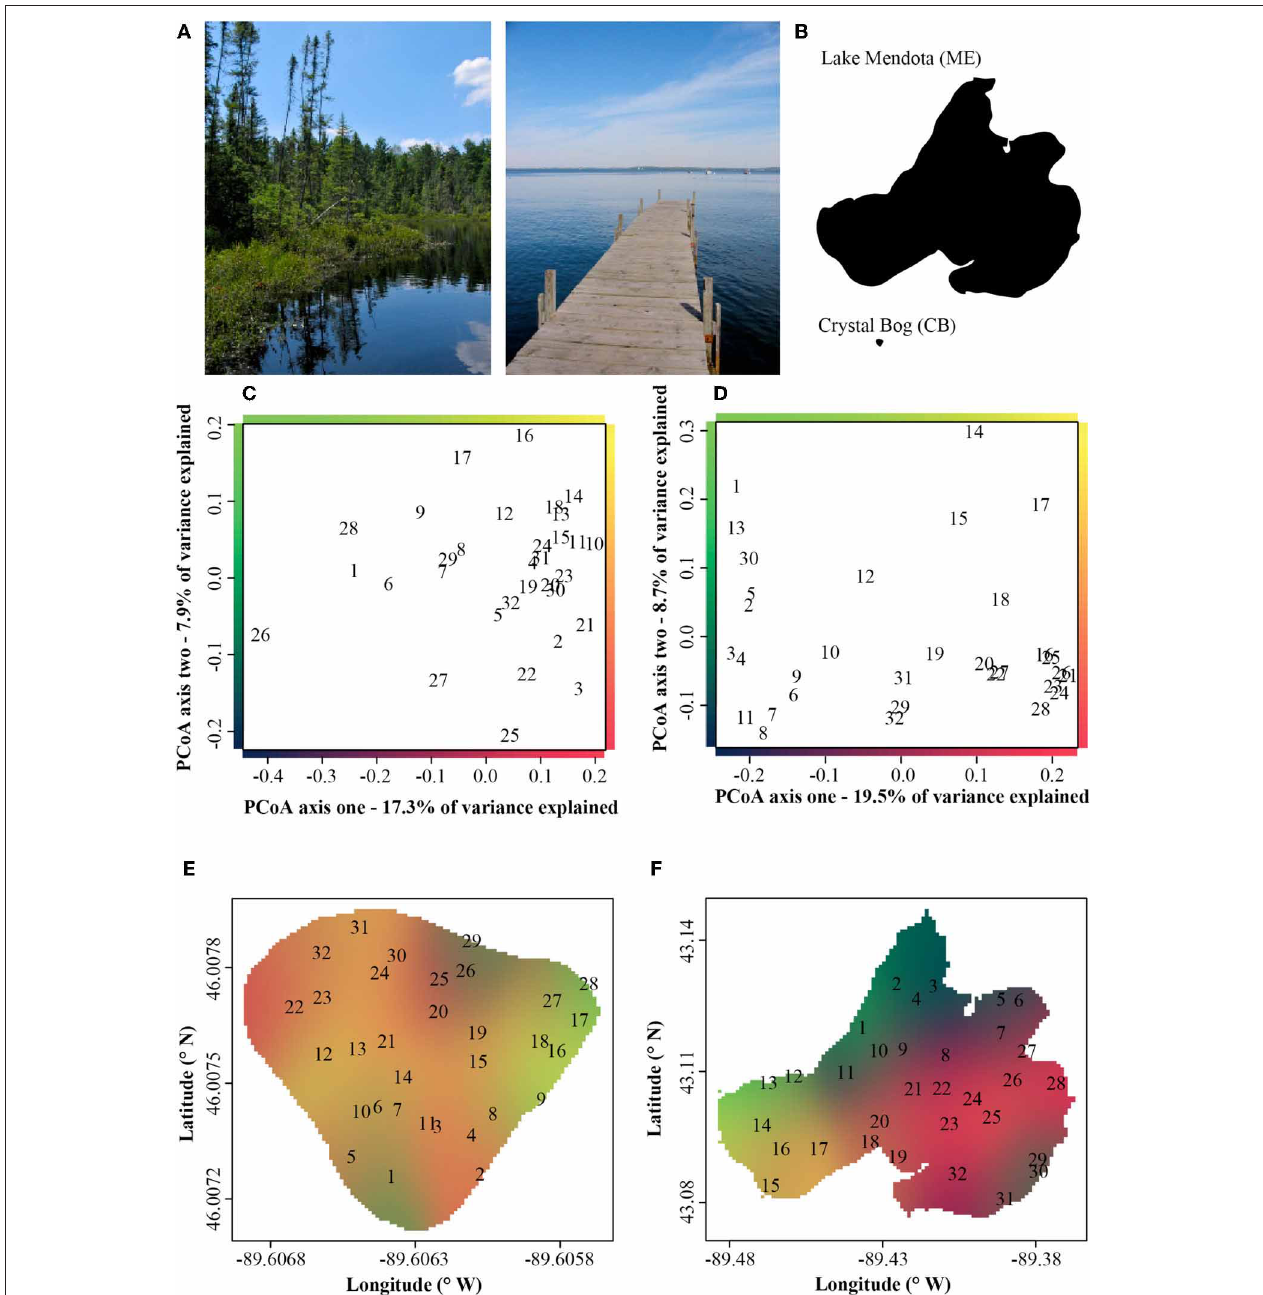
FIGURE 1 | (A) Pictorial and (B) areal contrast in the Lake Mendota (ME) and Crystal Bog (CB) environments. Principle coordinate analysis (PCoA) ordinations of bacterial community composition at 32 sites in Crystal Bog (C) and Lake Mendota (D) , collected on a single day. Points indicated as sample